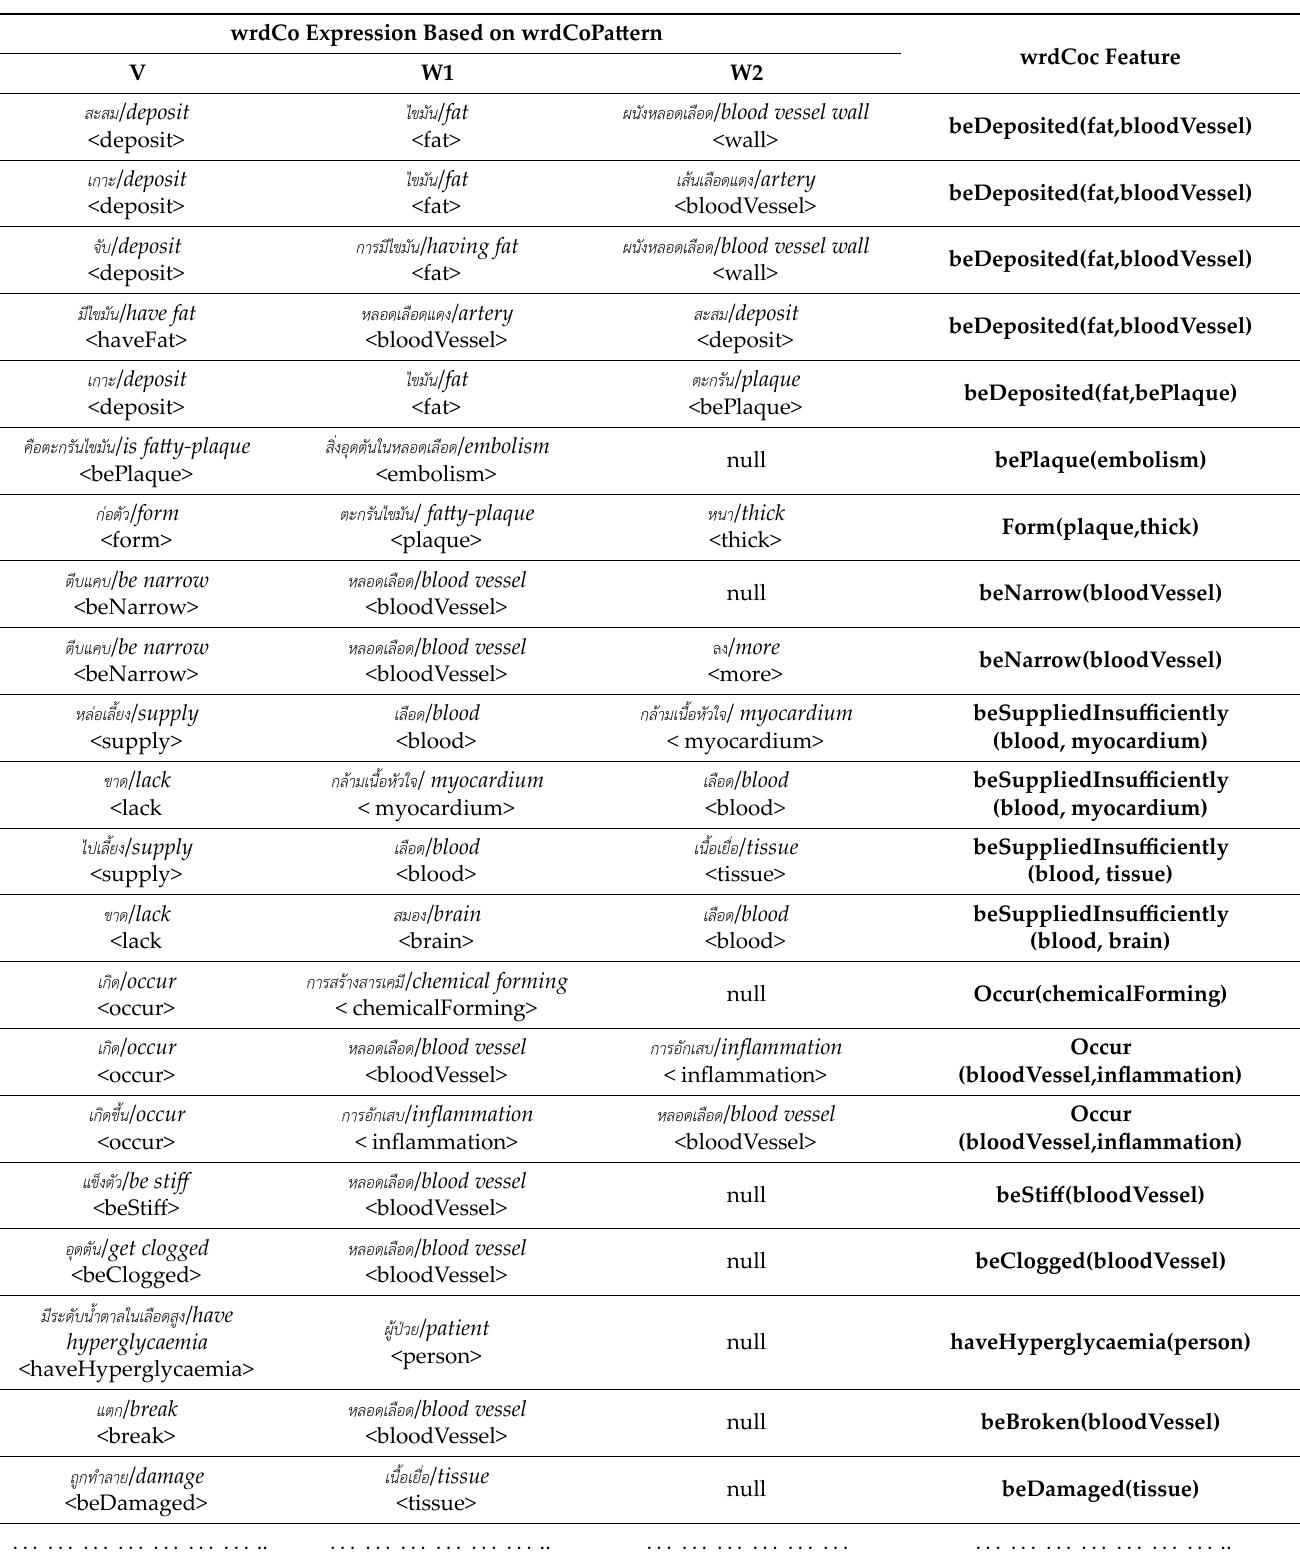
Table 1. wrdCo‑Concept Table from the annotated